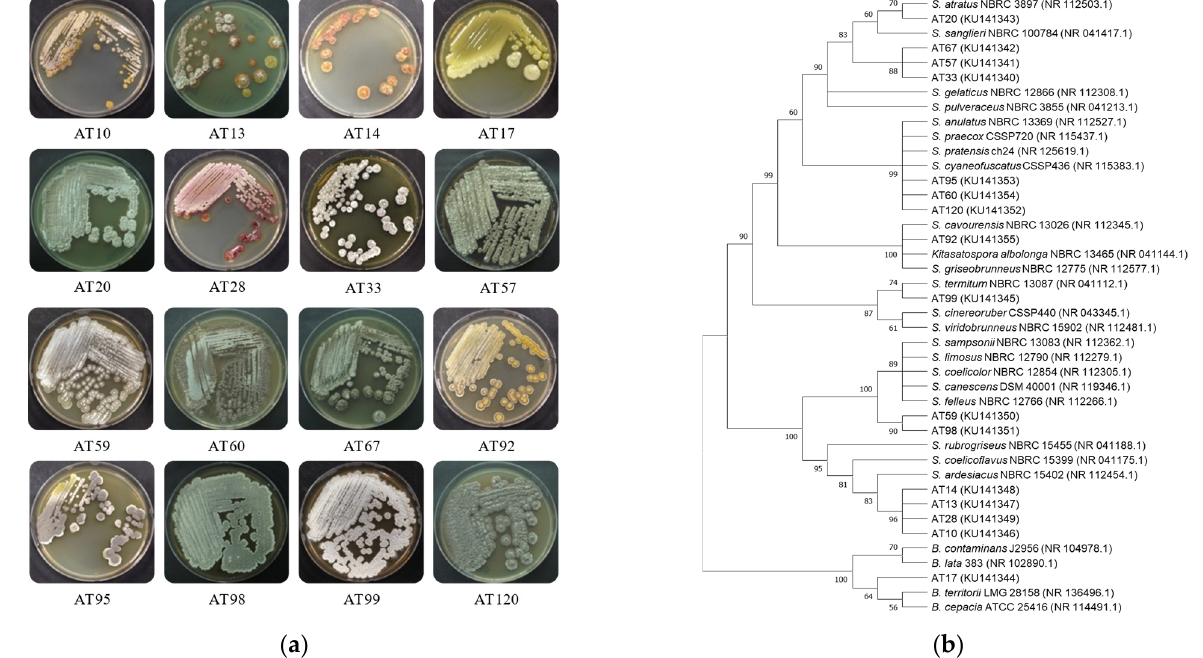
Figure 3. Antifungal bacterial strains isolated from dung beetles and brood balls. ( a ) Morphological characteristics of the 16 antifungal bacterial strains on YME agar plate after 20 days of cultivation. ( b ) Phylogenetic tree by Maximum Likelihood method based on the partial 16S rRNA gene of the 16 antifungal bacterial isolates and the close related members. Bootstrap values (>50%) obtained with 1000 re-samplings are given at the branch-points and branches in less than 50% are collapsed. GenBank accession numbers are indicated in parentheses. Bar, 0.02 nt substitutions per site.